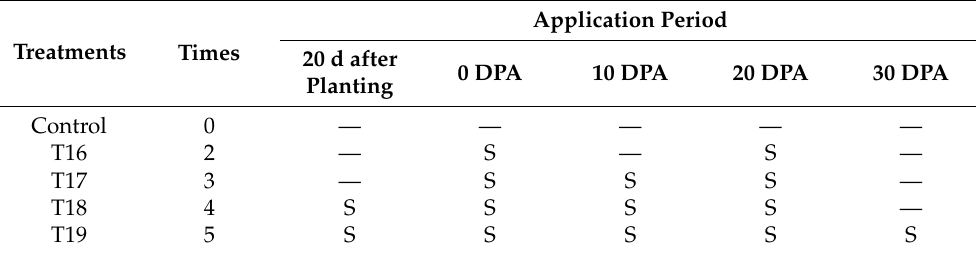
Table 2. NAA and EBR application period and